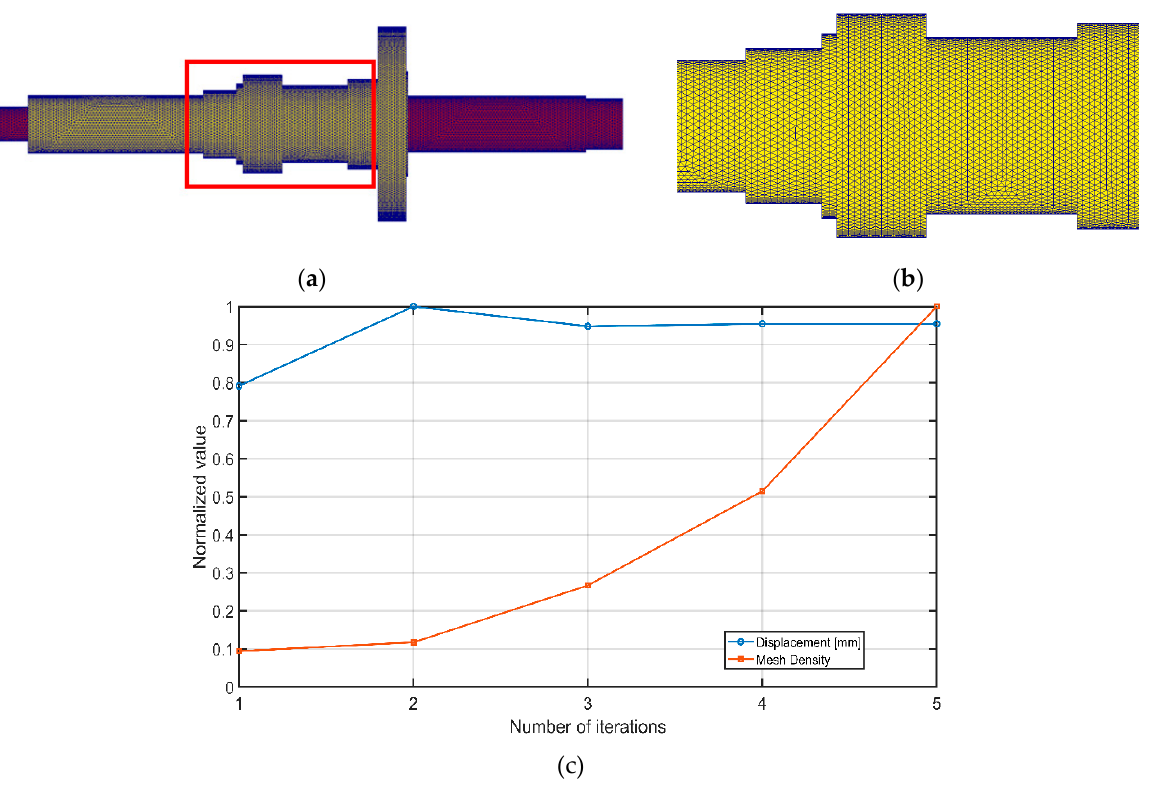
( b ) Figure 6. ICE +EM in 4th gear: ( a ) front view; ( b ) side view. 2.1.4. Numerical Simulation Parameters The mesh used for the FEM analysis is curvature-based tetrahedron mesh as shown in Figure 7a,b. The mesh density is chosen considering the computational cost and the convergence of the deflection results as shown in convergence plot in Figure 7c. It can be seen that the displacement results saturate with the increase of the mesh density. Hence, mesh with maximum element size of 1.5 mm is selected. The quality of the mesh elements